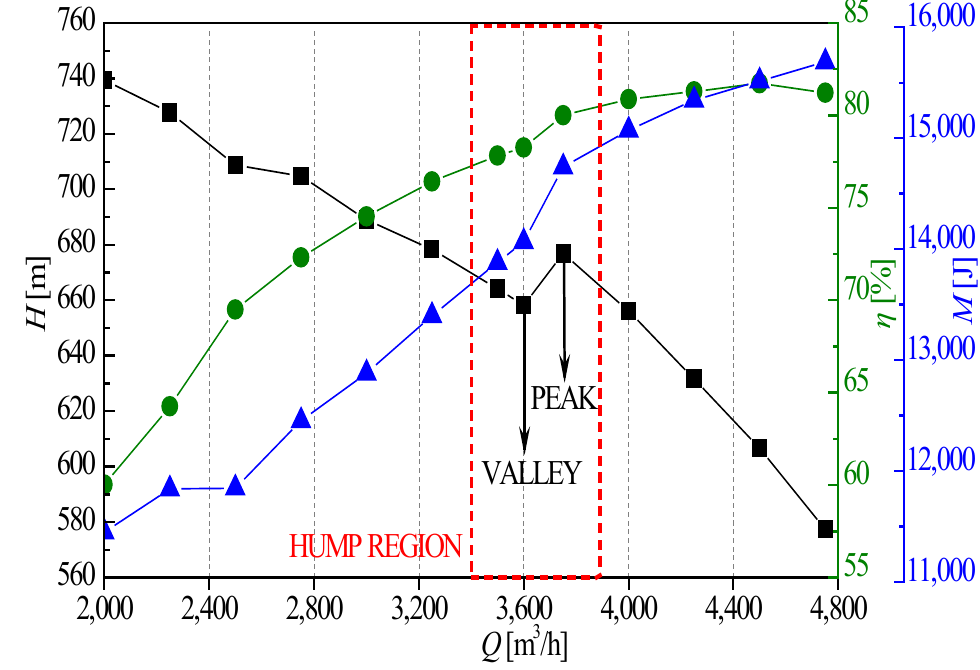
Figure 4. External characteristic curve.